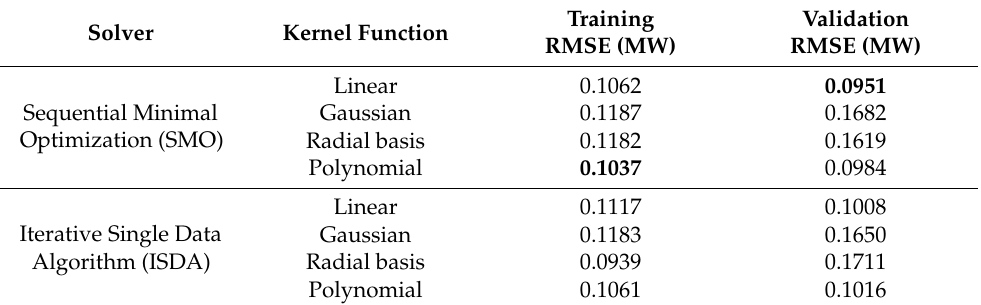
Table 6. Analyzed SVM structures’ averaged results for fixing solver and kernel function parameters.